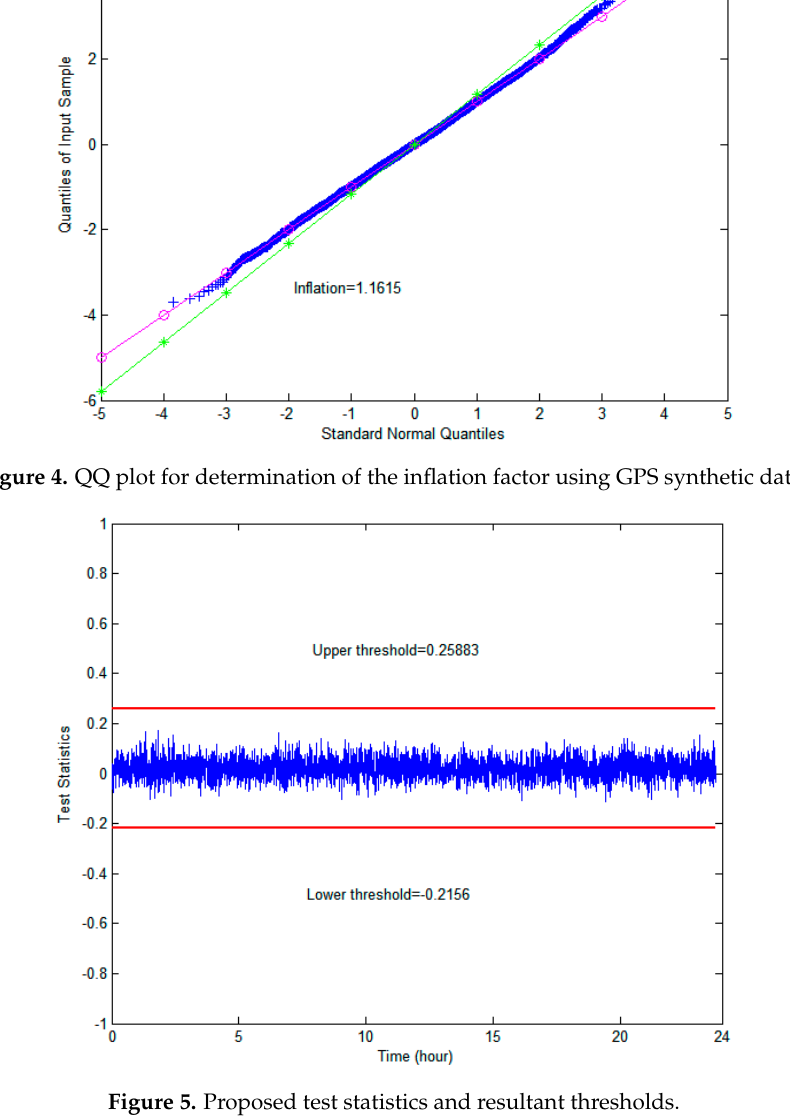
Figure 5. Proposed test statistics and resultant thresholds.